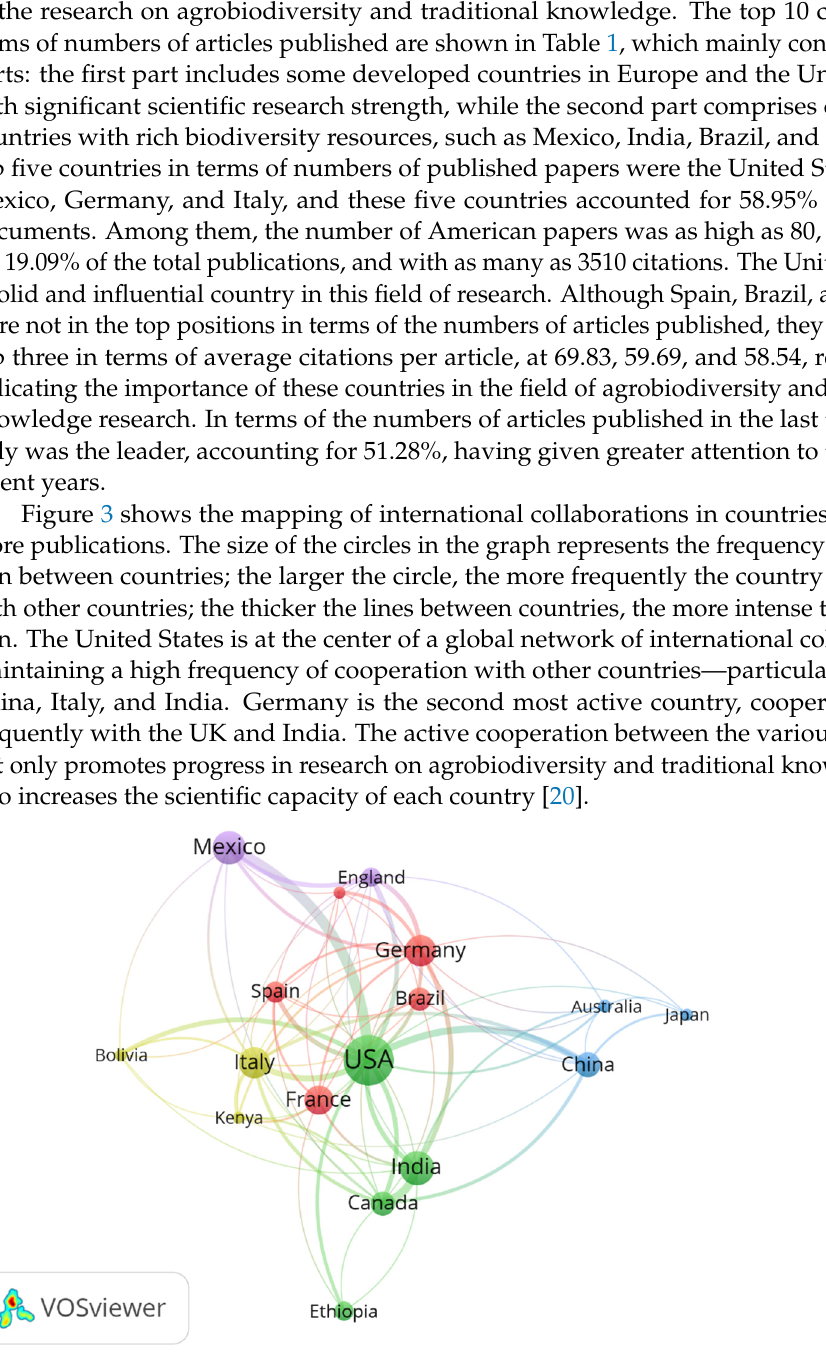
Table 1. Top 10 countries or regions in the number of publications.